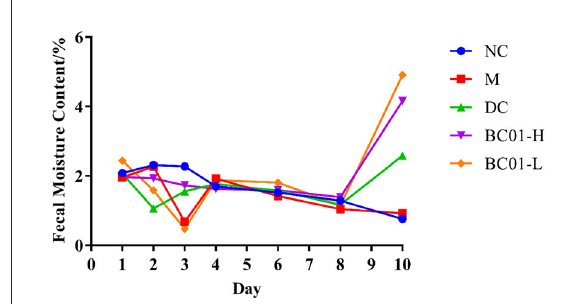
FIGURE2 Changes of fecal moisture content in mice. NC, normal group; M, constipation model group; DC, bisacodyl control group;